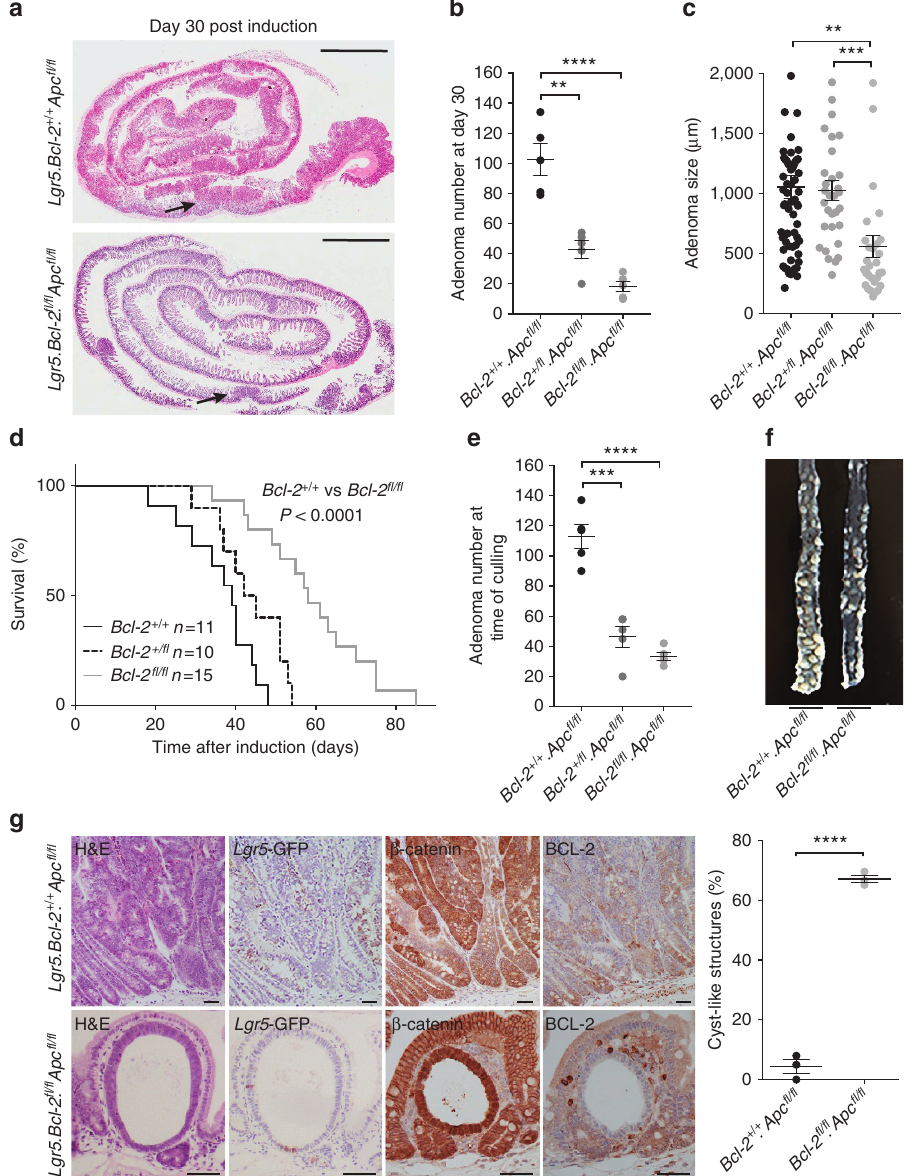
Figure 4 | Bcl-2 loss impairs adenoma formation. ( a ) Representative hematoxylin and eosin (H&E) stained sections of two small intestines of the Lgr5 . Bcl-2 þ / þ . Apc fl/fl and Lgr5 . Bcl-2 fl/fl . Apc fl/fl mice at day 30 post induction. Arrows indicate an adenomatous lesion. Scale bars, 2mm. ( b ) Graph showing the number of adenomas at day 30 post induction for Lgr5 . Bcl-2 þ / þ . Apc fl/fl , Lgr5 . Bcl-2 þ /fl . Apc fl/fl and Lgr5 . Bcl-2 fl/fl . Apc fl/fl mice. Each dot represents a mouse ( n ¼ 5), error bars represent s.e.m. ** P o 0.01, **** P o 0.0001, Student’s t -test. ( c ) Graph showing the adenoma size at day 30 post induction in Lgr5 . Bcl-2 þ / þ . Apc fl/fl , Lgr5 . Bcl-2 þ /fl . Apc fl/fl and Lgr5 . Bcl-2 fl/fl . Apc fl/fl mice. Each dot represents a measurement of the adenoma size (minimal n ¼ 32 per genotype), error bars represent the s.e.m. ** P o 0.01, *** P o 0.001, Student’s t -test. ( d ) Kaplan–Meier plot demonstrating the surviving fraction at the indicated time points post induction of Lgr5 . Bcl-2 þ / þ . Apc fl/fl , Lgr5 . Bcl-2 þ /fl . Apc fl/fl and Lgr5 . Bcl-2 fl/fl . Apc fl/fl mice (minimal n ¼ 10 mice per genotype). P value by log-rank test. ( e ) Graph indicating the number of adenomas per mice at the time of culling in the survival analysis ( n ¼ 4). Error bars represent the s.e.m., *** P o 0.001, **** P o 0.0001, Student’s t -test. ( f ) Representative images of distal part of the small intestines of Lgr5 . Bcl-2 þ / þ . Apc fl/fl and Lgr5 . Bcl-2 fl/fl . Apc fl/fl mice, included in the survival analysis, at the time of termination. ( g ) Representative immunohistochemical panel of Apc -deficient adenomas (top panel) and cyst-like structures (bottom panel) in the small intestines of mice of the indicated genotypes 30 days after induction; H&E (left), Lgr5 -GFP (middle-left), b -catenin (middle-right) and BCL-2 (right) staining. Scale bars, 50 m m. The graph displays the fraction of cyst-like structures observed in mice of the indicated genotypes at moment of termination. Each dot represents a mouse ( n ¼ 3), error bars represent the s.e.m. **** P o 0.0001, Student’s t without Bcl-2 overexpression following inactivation of Apc overexpression greatly enhanced the capacity for clonogenic (Fig. 7d). In all cases Bcl-2 overexpression increased the outgrowth of differentiated CD44 low cells that underwent Apc inactivation (Fig. 7d). This result suggests that Bcl-2 proportion of clonogenic cells likely reflecting that it prevents overexpression can support transformation in differentiated apoptosis caused by cellular stress associated with FACS sorting cells not normally capable of clonogenic outgrowth. and single-cell plating. However, most importantly, Bcl-2